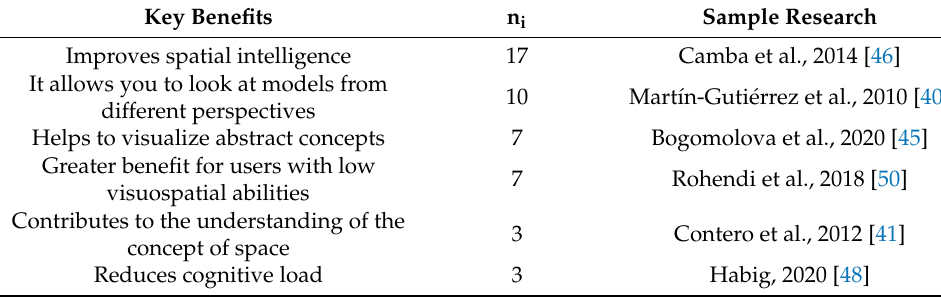
Table 6. Benefits of AR in the development of spatial